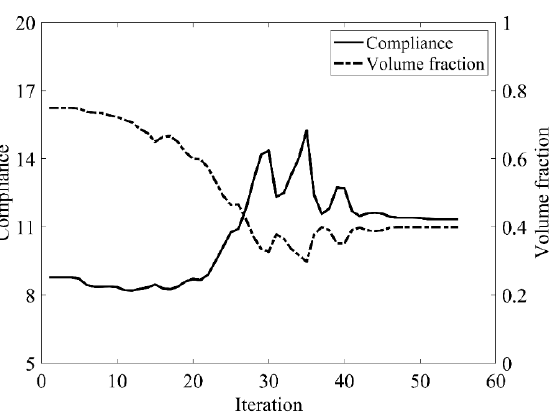
Figure 21. Convergence history of the compliance and the volume fraction for simple bridge beam by CBT level set topology optimization.